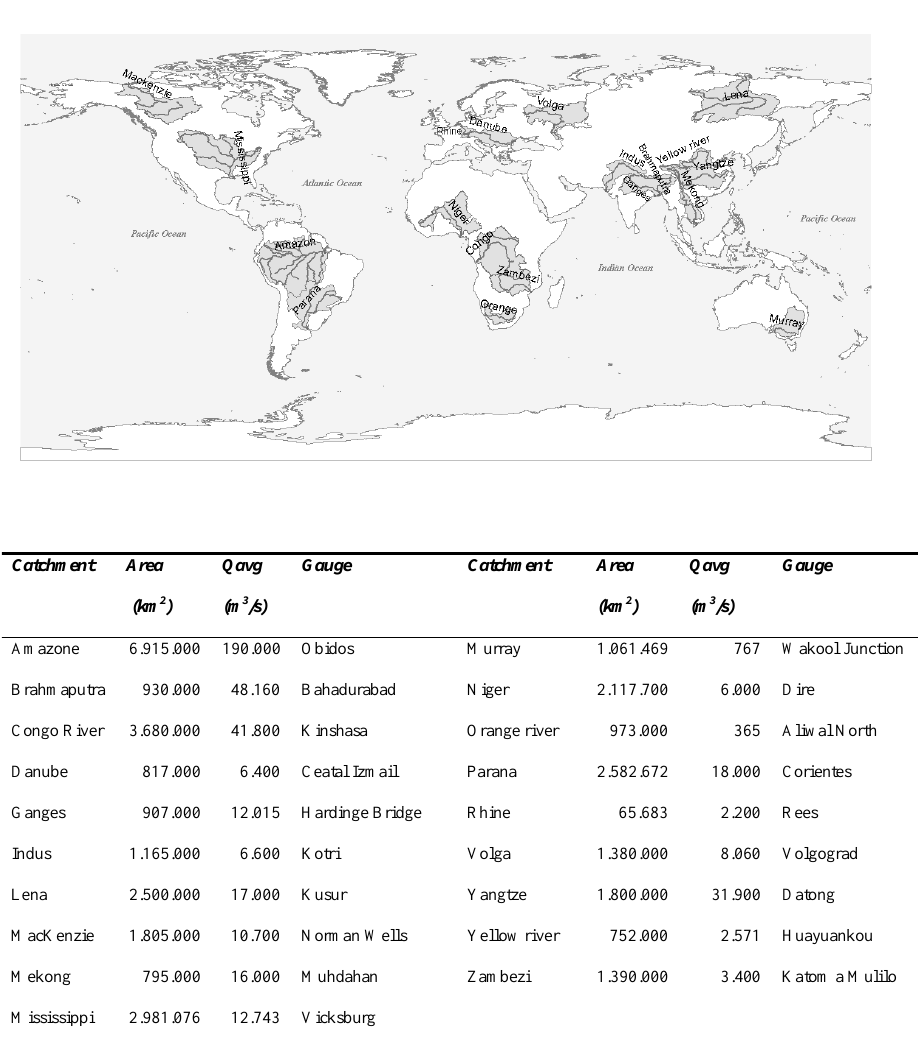
Figure 1: Selected catchments2 Fig. 1. Selected